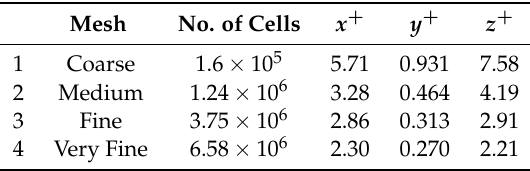
Table 2. A mesh independence study was performed on four mesh densities; coarse, medium, fine, and very fine mesh. The corresponding no. of cells and dimensionless wall units x + , y + z + for each mesh are